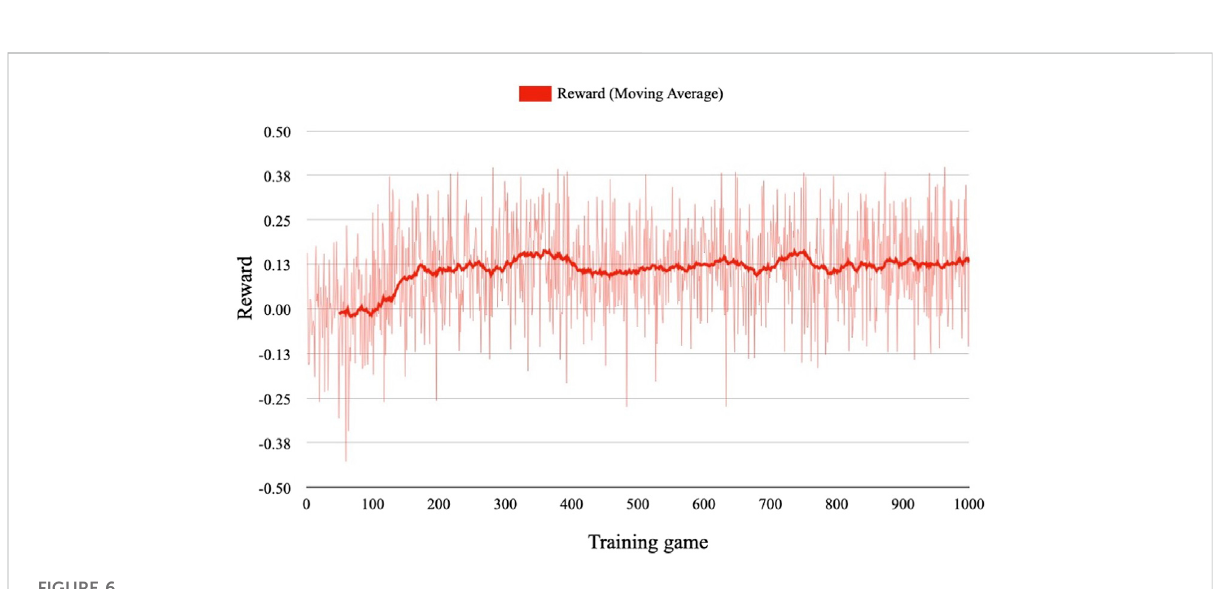
FIGURE 6 Variation of reward and its moving average in training